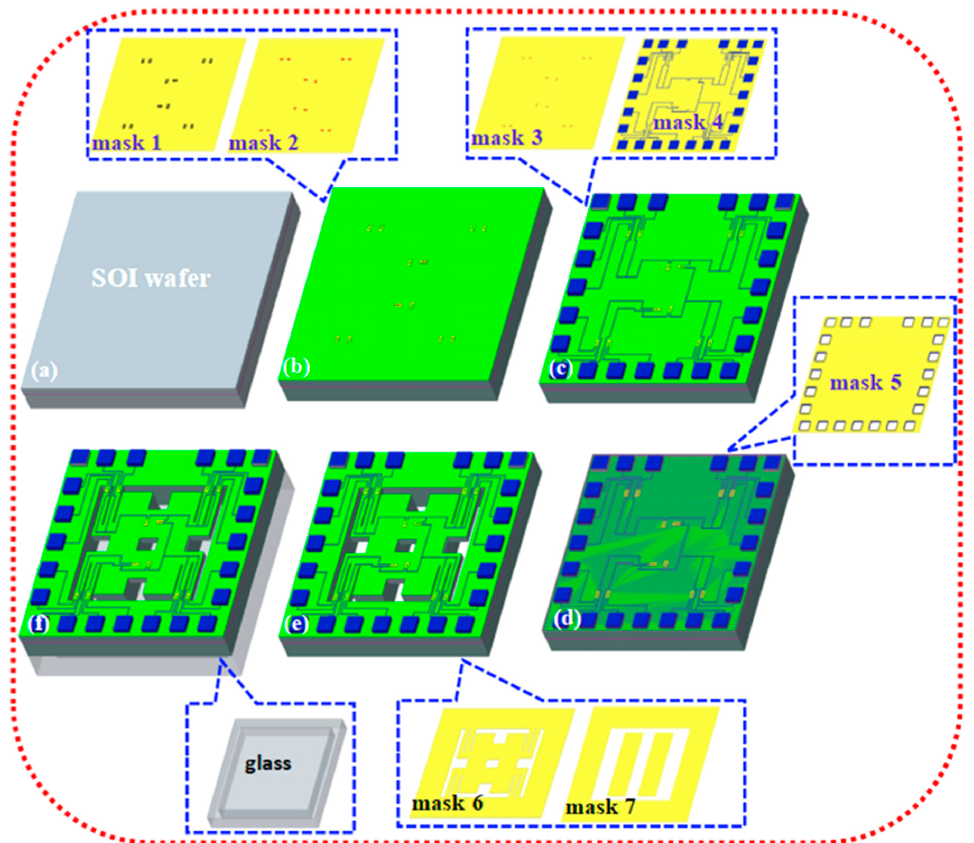
Figure 5. The main fabrication process of the proposed sensor (insets of mask1-mask7 used for photolithography and bonding glass): ( a ) cleaning the wafer; ( b ) forming p + and p- regions; ( c ) performing contact holes to fabricate the electrodes and interconnects; ( d ) forming pad; ( e ) ICP etching the top and bottom surfaces of the chip to release the beam structure; and ( f ) bonding a glass plate with the bottom surface of chip.